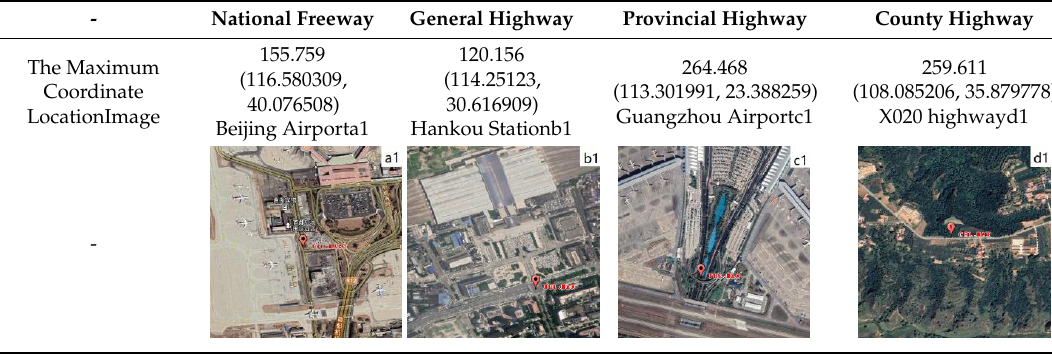
Table 3. Table 3. Table 3. Table 3. List of the maximum points of the four highway grades nighttime light. Table 3. List of the maximum points of the four highway grades nighttime light. Table 3. List of the maximum points of the four highway grades nighttime light. Table 3. List of the maximum points of the four highway grades nighttime light. Table 3. List of the maximum points of the four highway grades nighttime light. Table 3. List of the maximum points of the four highway grades nighttime light.